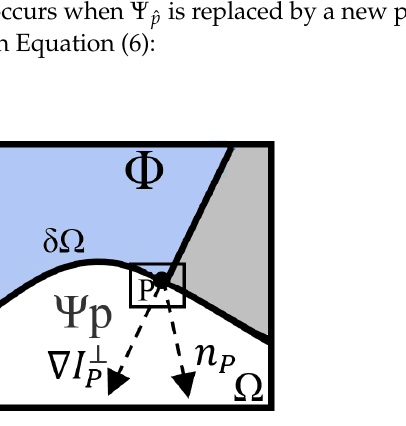
Figure 3. The process diagram of calculating the filling priority of image edge